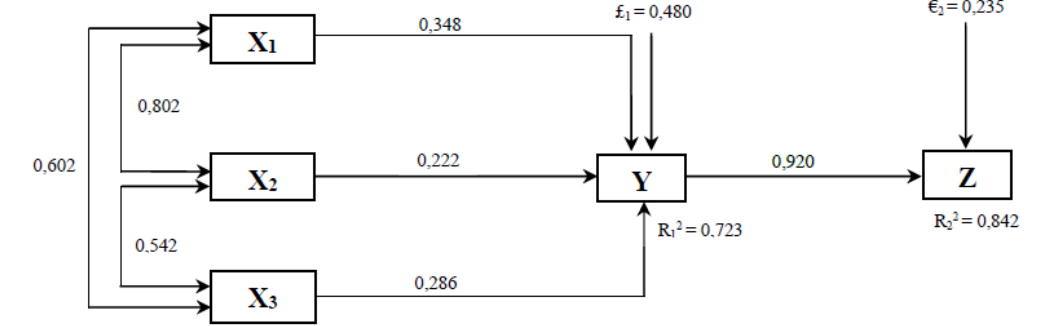
Figure 12. The Relationship of Natural Resource Management, Economic Empowerment, Strengthening Community Capacity, Towards Economic Business Productivity and Ecosystem Sustainability.